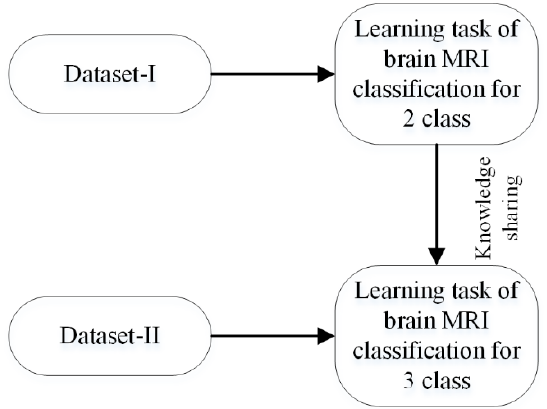
Figure 2. Process of transfer learning for brain-image classification.